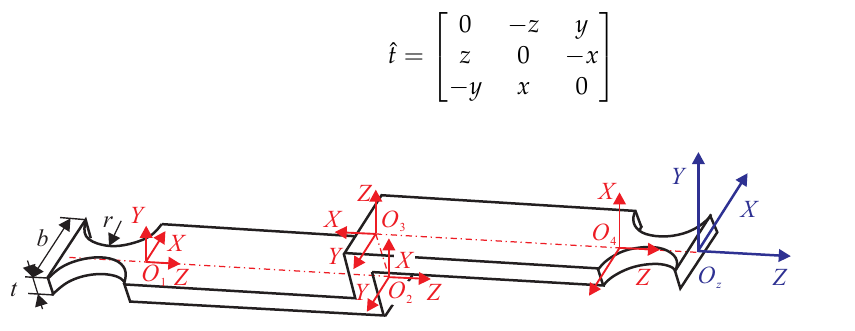
Figure 4. Schematic diagram of a Z-shaped flexure hinge.